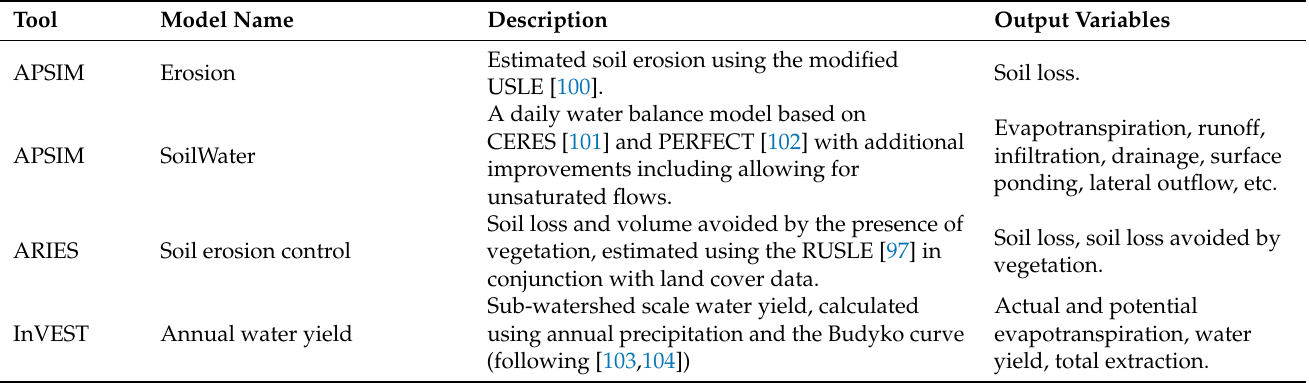
Table 6. Summary of the shortlisted tools and associated models that quantify erosion, runoff, and flood